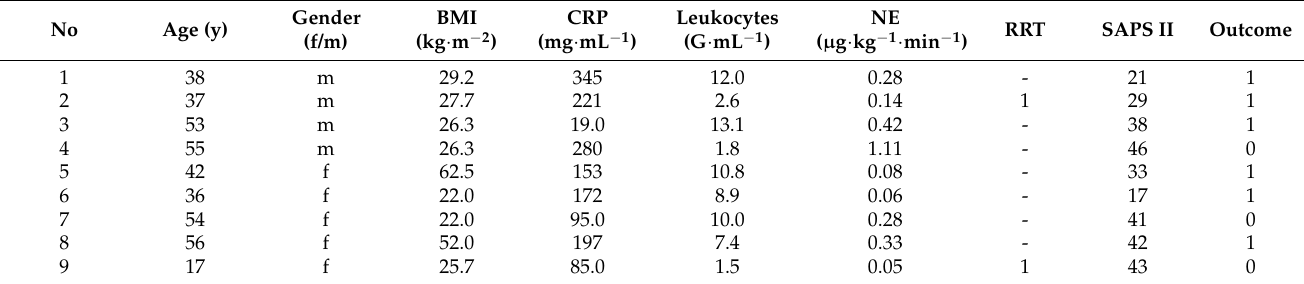
Table 1. Characteristics of patients at the time of first breath gas analysis.